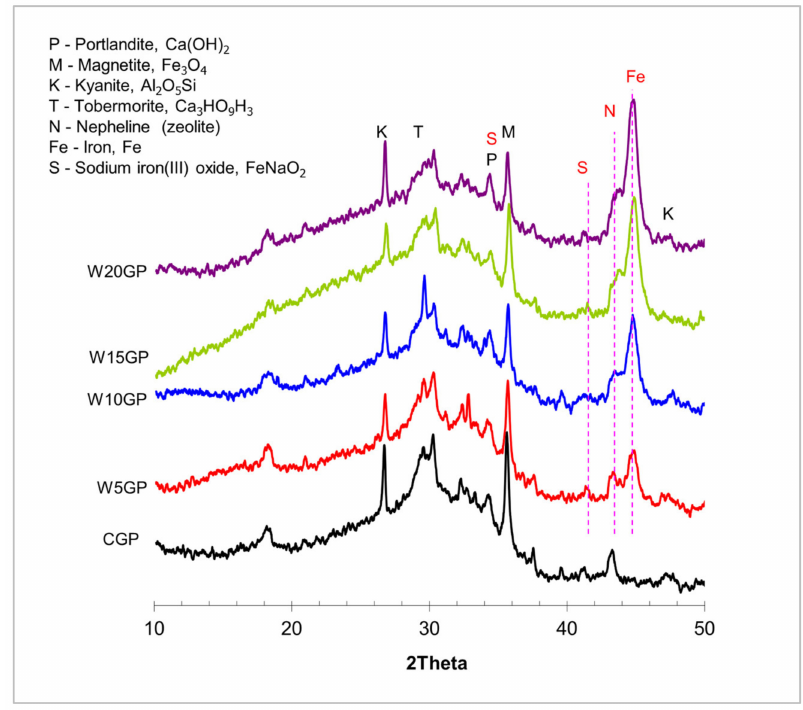
Figure 9. XRD patterns analysis of 28 day–aged CGP and WGP